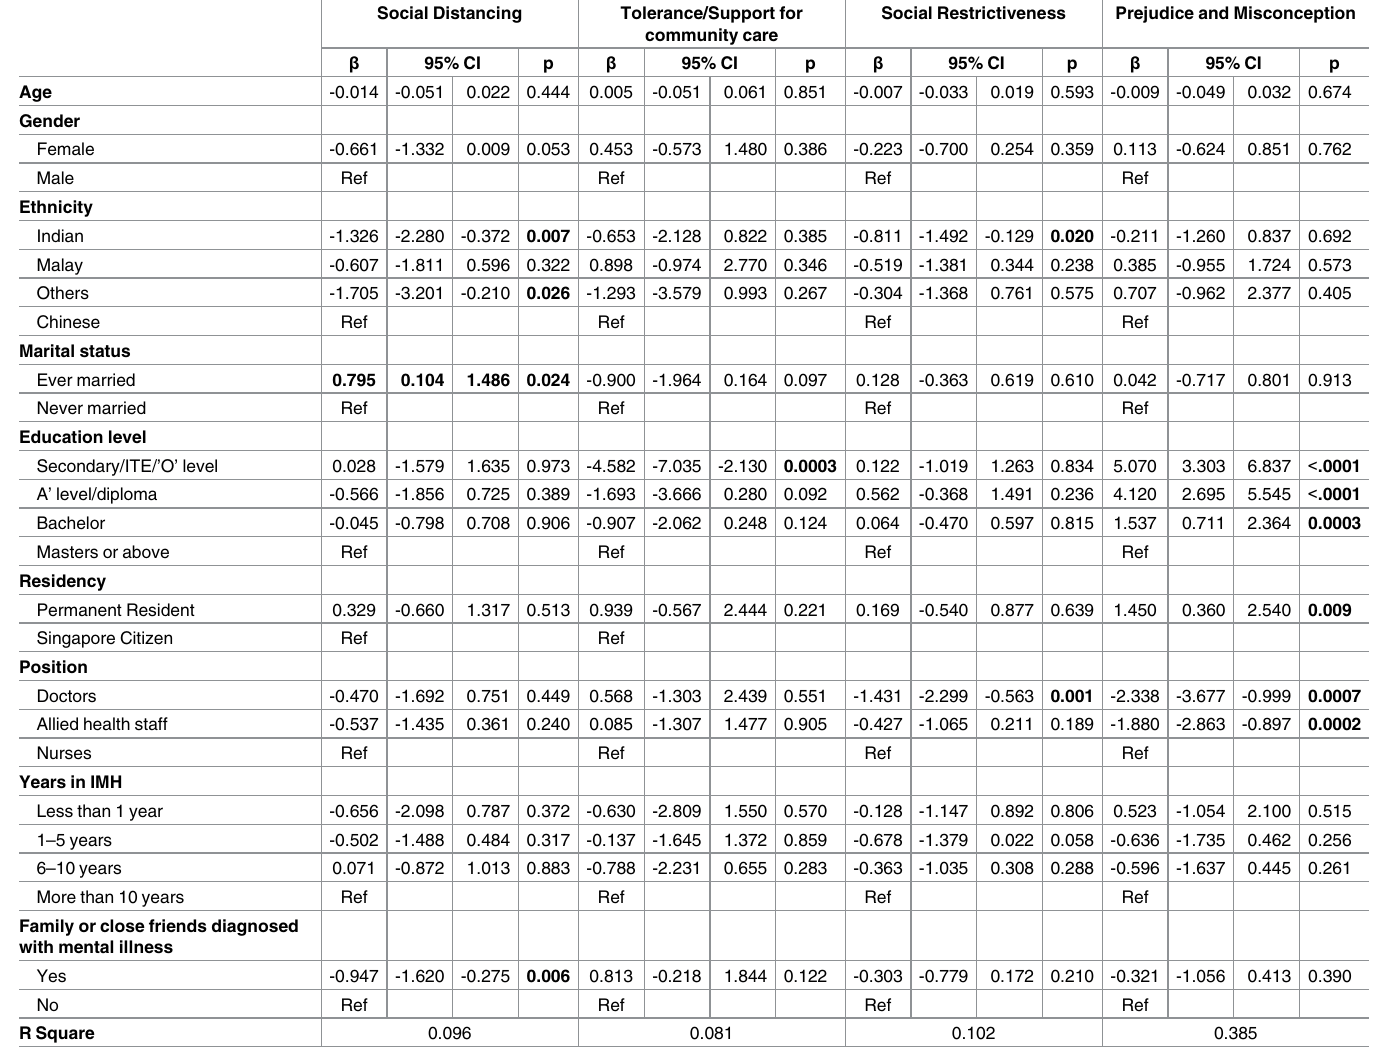
Table 4. Correlates of AMI-SG factor scores among mental health